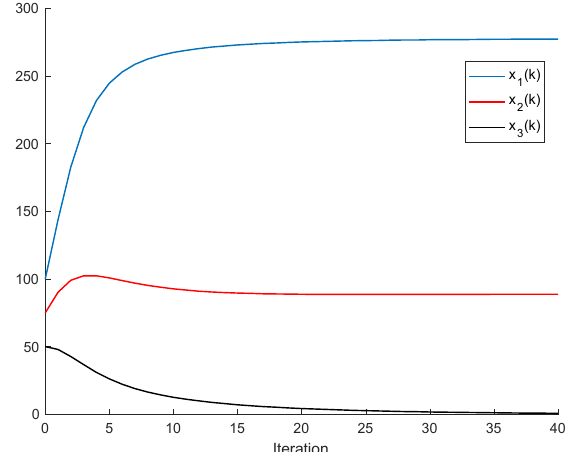
Figure 6. Evolution of x 1 ( k ), x 2 ( k ) and x 3 ( k ) for constant parameters in Example 4 when species 1 dominates the other two. In this case, there is neither harvesting nor external consumption.